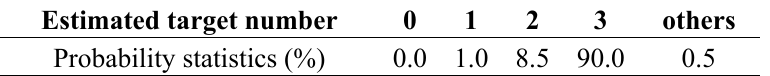
Table 3. Probabilities of correct target number estimation (200 runs, Scenario-3).